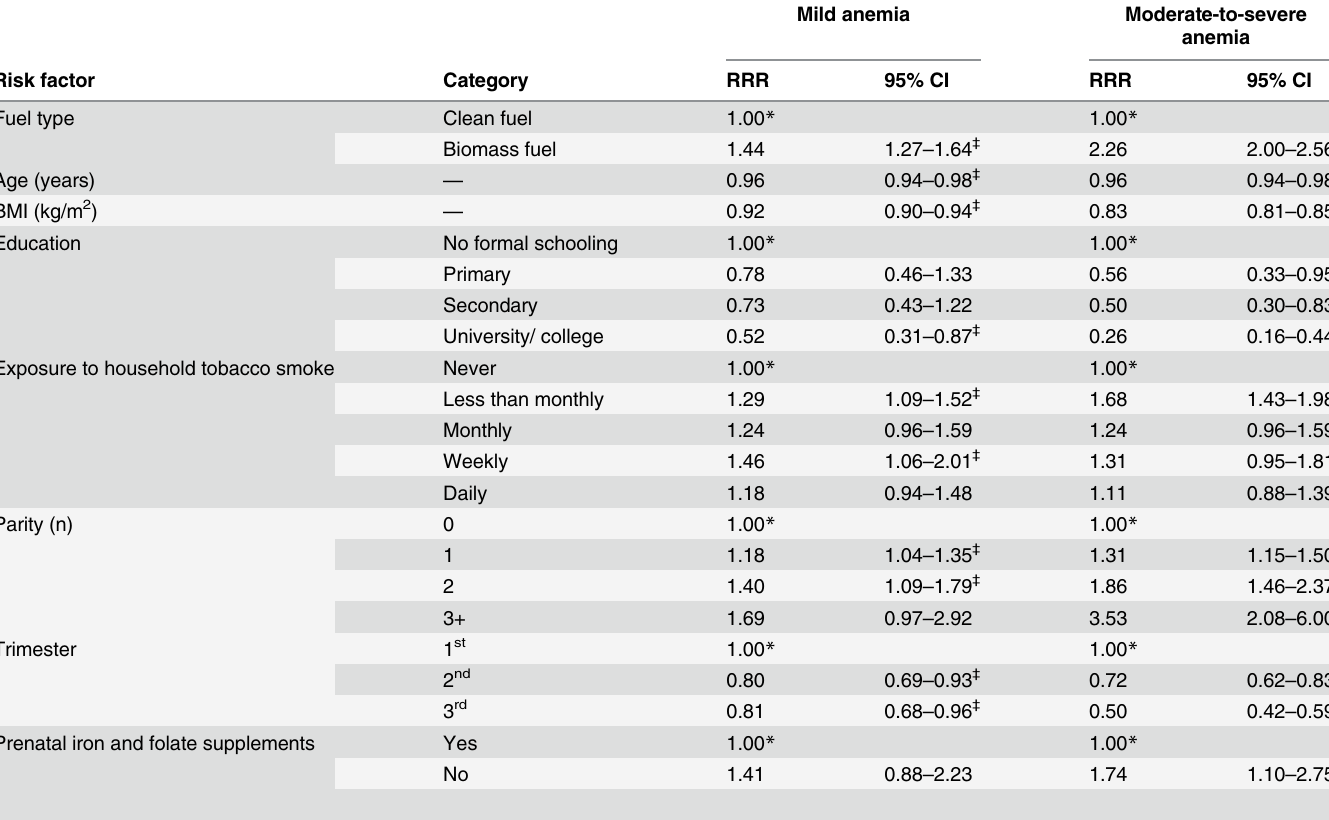
Table 2. Bivariate analysis of risk factors for anemia in pregnant women in Nagpur, India, 2011 – 2013 (N = 12,782).